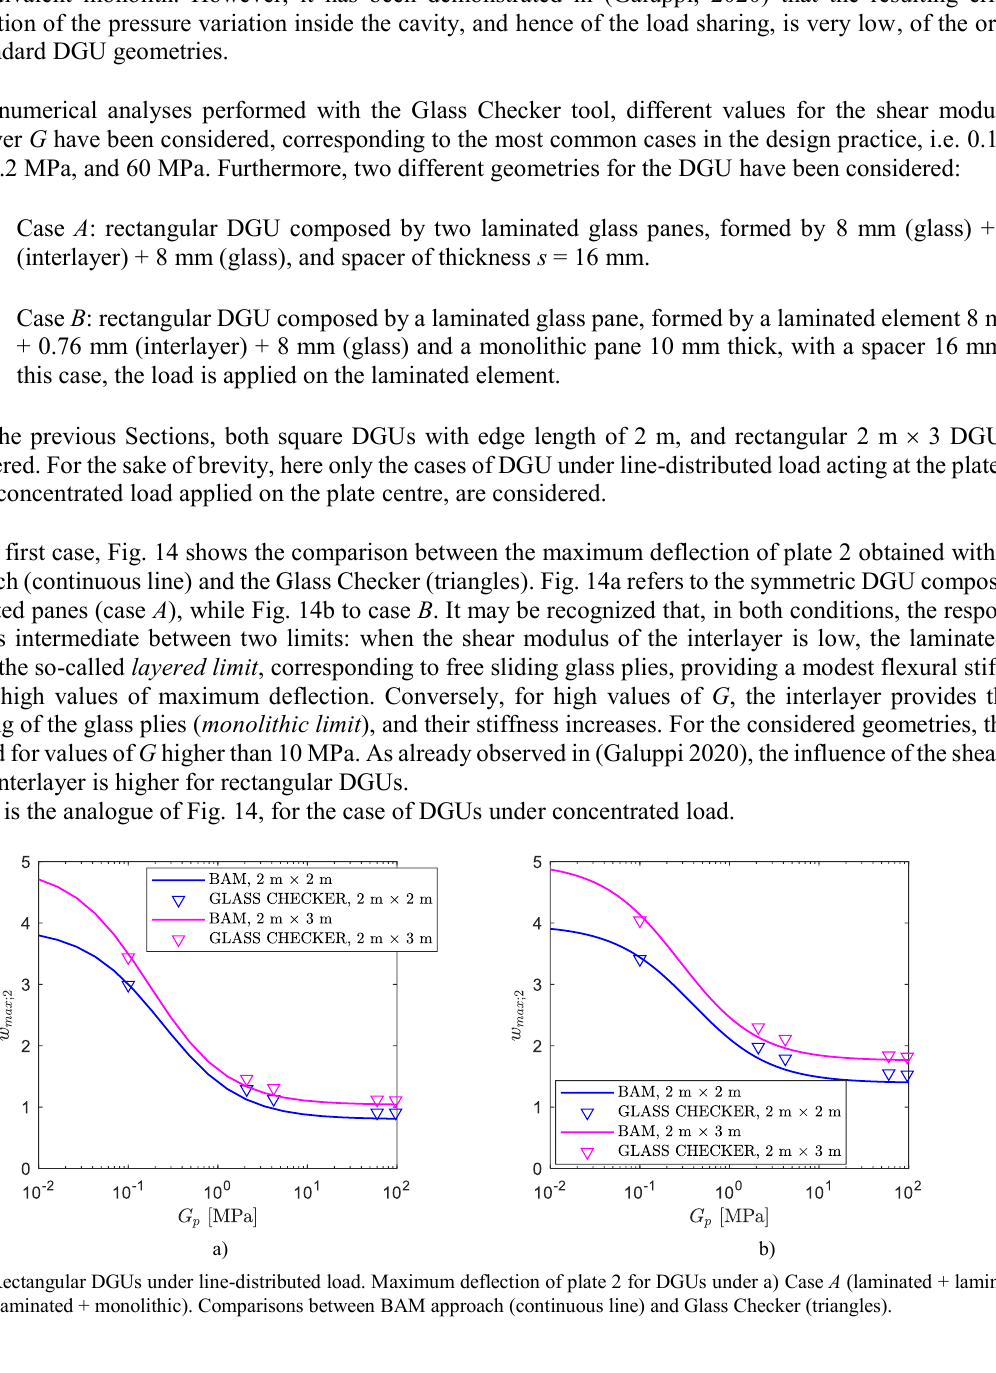
1 For rectangular panels, the case a = 2m, b = 3 m, corresponding to a line load applied on the shorter edge, is